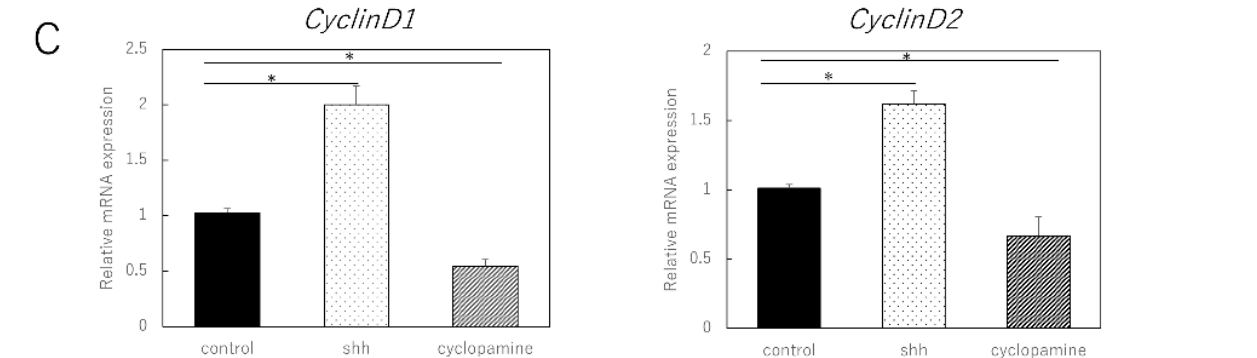
Figure 4. Effect of Shh on epidermal cells in vitro. ( A ) Comparison of migration ability using a scratch assay. ( B ) Comparison of the cell proliferation rate. * p < 0.05. ( C ) Comparison of the expression of cyclin D genes. * p < 0.05.